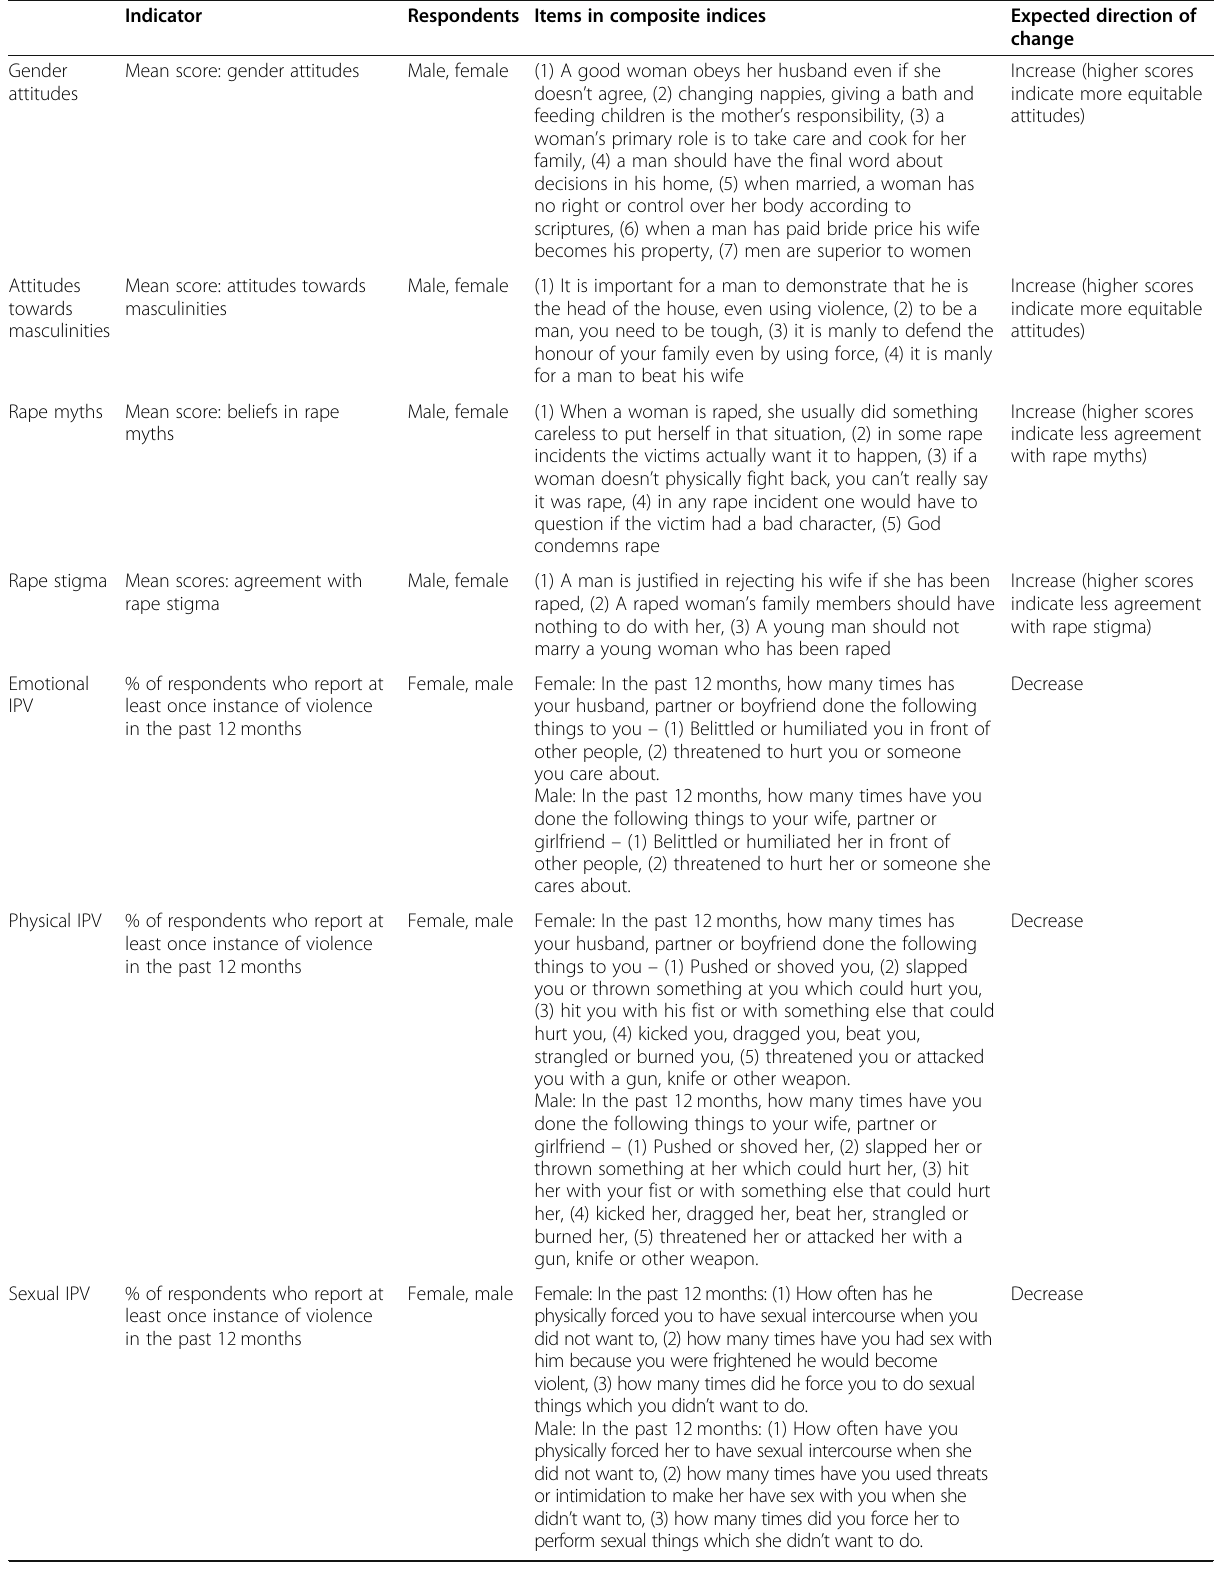
Table 2 Questionnaire items used to construct